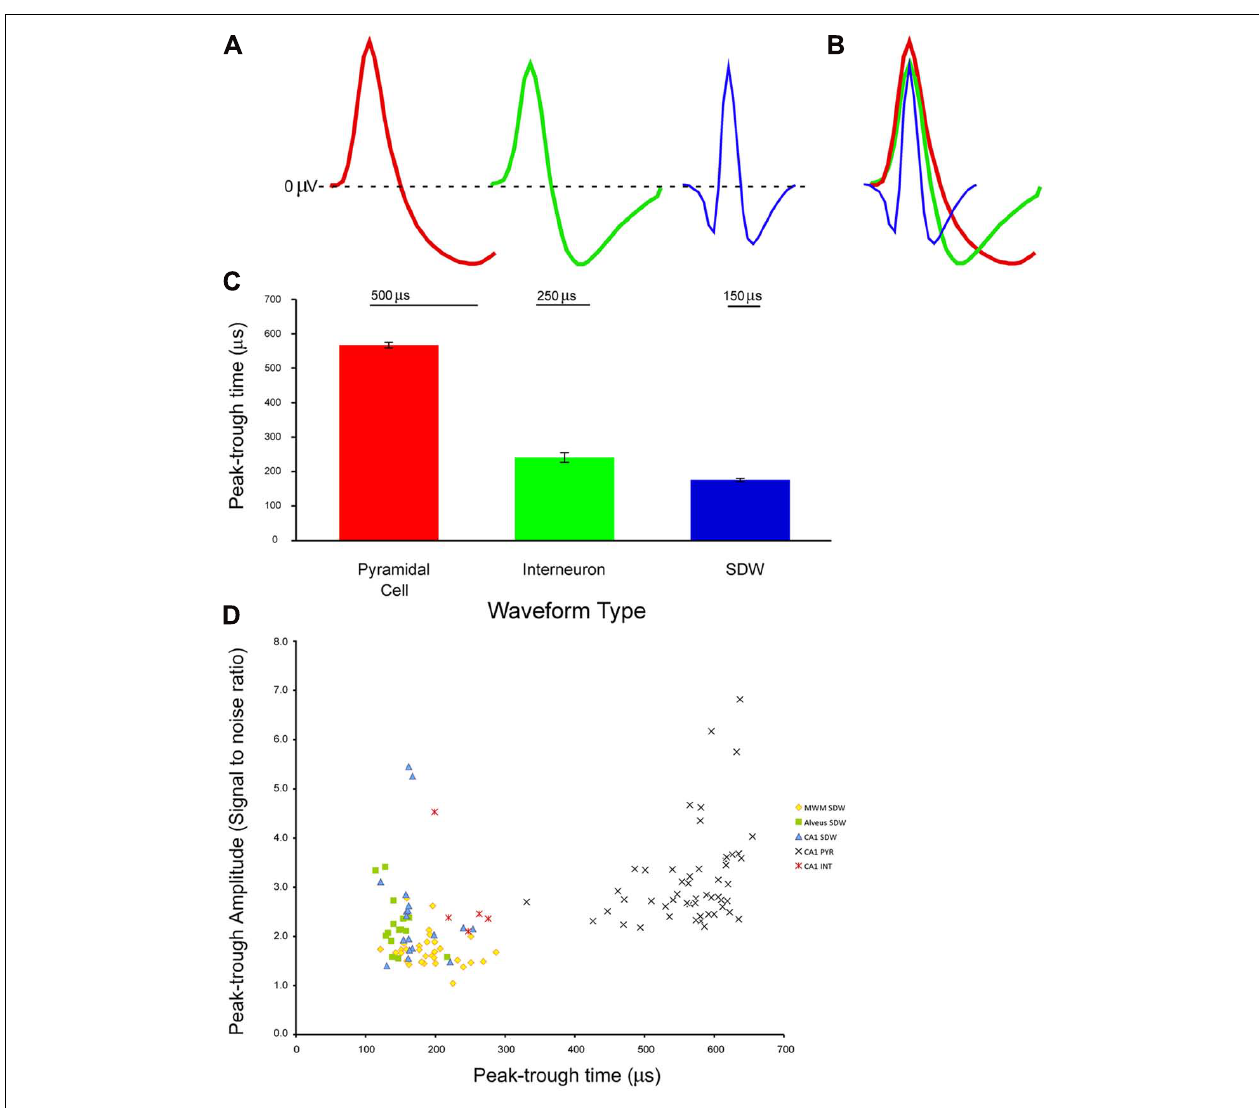
FIGURE 1 | Example of waveforms from extracellular tetrode recordings in the hippocampus from different cell types and a putative axon: (A) pyramidal cell, interneuron, and short duration waveform. The pyramidal cell (red) has an average spike width of 500 μ s with a long lasting hyperpolarization. The interneuron (green) has a shorter spike width of 250 μ s with a shorter hyperpolarization period. The third example is of a short duration waveform that is triphasic, exhibiting a brief hyperpolarization period before and after a brief depolarization; (B) overlay of the three average waveforms; (C) average